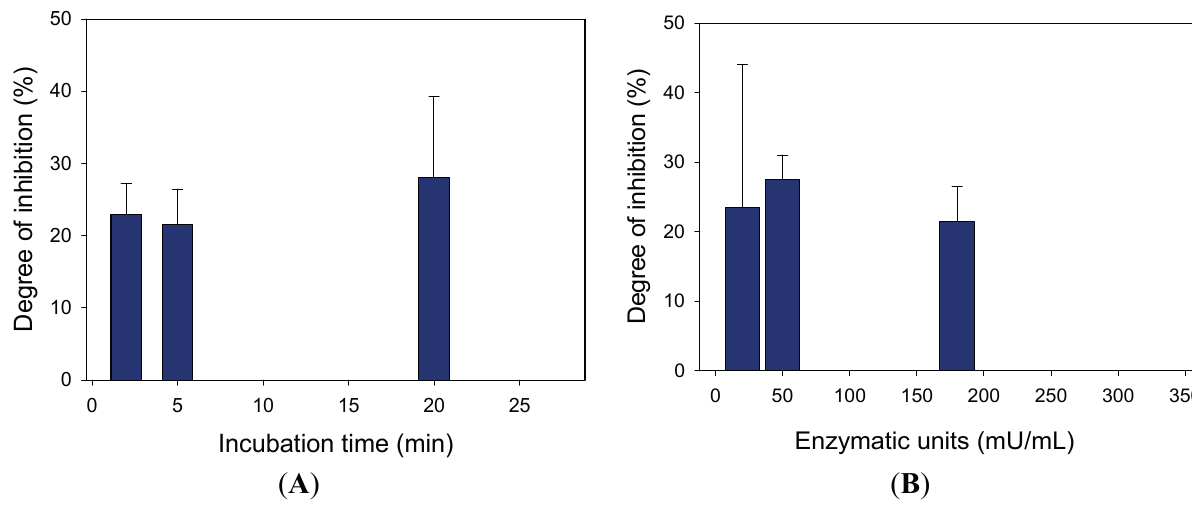
Figure 7. ( A ) Study of percentage inhibition vs. incubation time. Choline oxidase concentration: 180 mU/mL; choline concentration: 0.5 mM; 2-chloroethyl ethyl sulfide concentration: 0.01 mM; Phosphate buffer 0.05 M + 0.1 M KCl, pH 7.4; potential: − 50 mV vs. Ag/AgCl; ( B ) Study of percentage inhibition vs enzymatic units. Choline concentration: 0.5 mM; 2-chloroethyl ethyl sulfide concentration: 0.01 mM; Phosphate buffer 0.05 M + 0.1 M KCl pH 7.4; potential: − 50 mV vs. Ag/AgCl; incubation time: 120 s. Measurements were carried out in